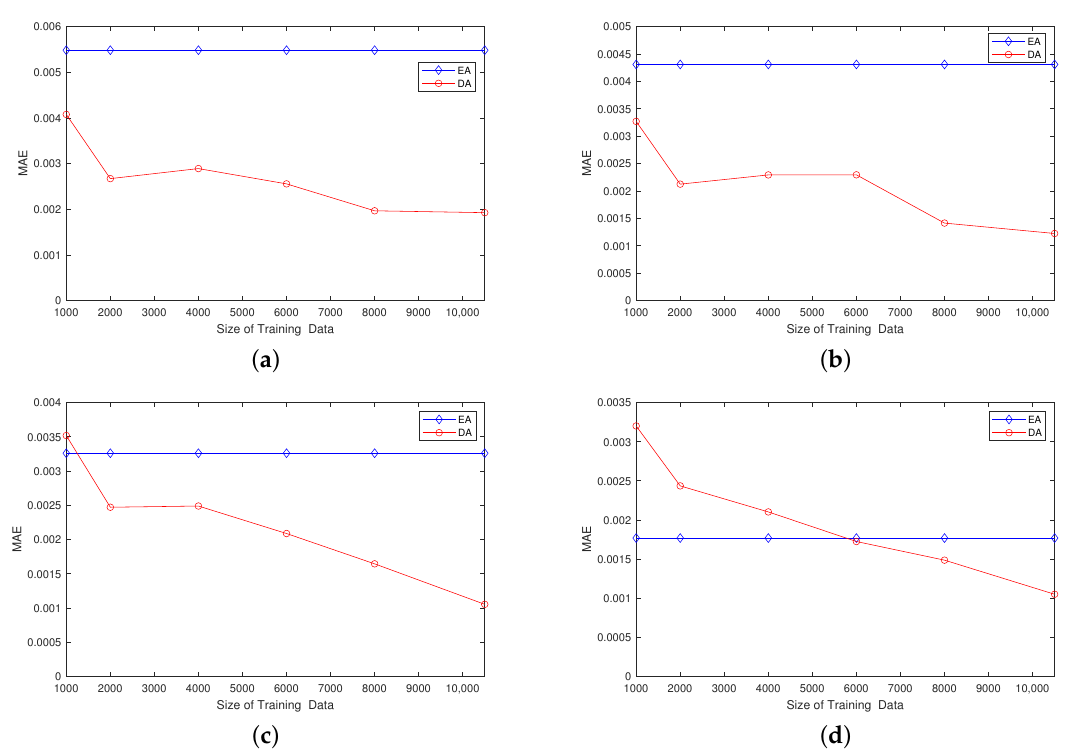
Figure 5. MAE for varying the size of training datasets. ( a ) (cid:101) = 0.1; ( b ) (cid:101) = 0.5; ( c ) (cid:101) = 1.0; ( d ) (cid:101) =